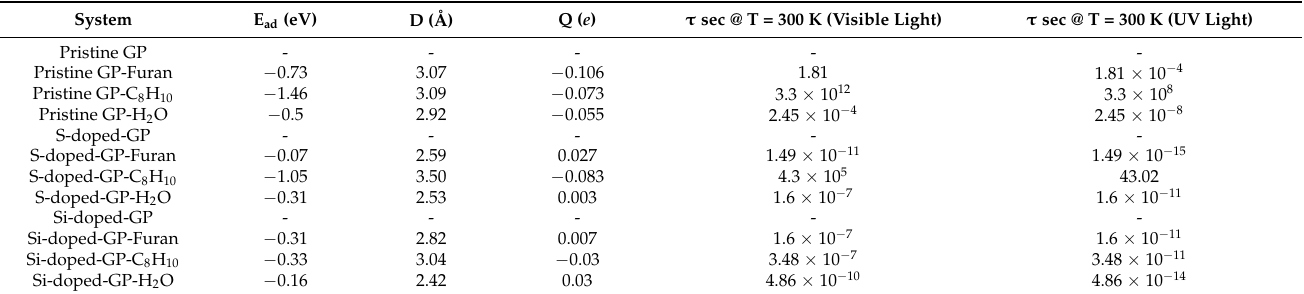
Table 1. The calculated adsorption energy (E ad ), interaction distance (D)—i.e., the distance between the molecule and the GP sheet, charge transfer (Q), where negative values of charge indicate a charge transfer from the molecule to the surface, and recovery time ( τ